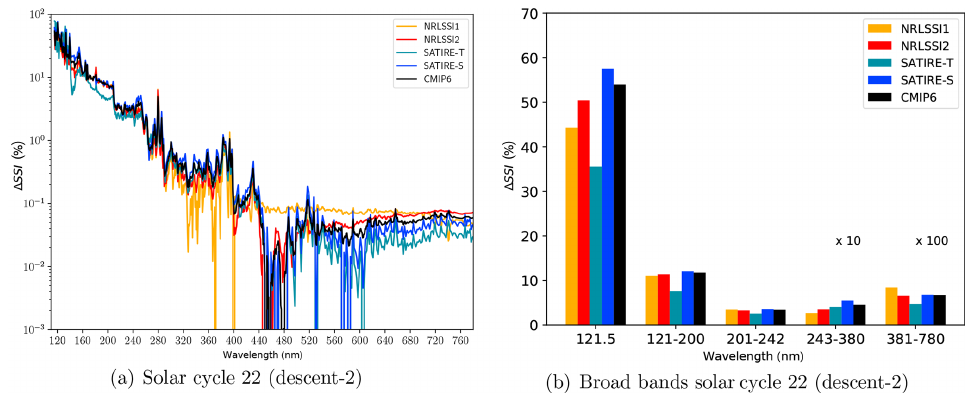
Figure 1. (a) Solar cycle SSI variations from November 1989 to November 1994 relative to November 1994 ( (cid:49) SSI) in percent for wave- lengths ranging from FUV to the visible bands; (b) as in (a) for the Lyman- α (121.5nm), far-UV (121–200nm), Herzberg continuum–Hartley bands (201–242nm), and Hartley and Huggins bands (243–380nm) (multiplied by a factor of 10) and visible (381–780nm) (multiplied by a factor of 100).